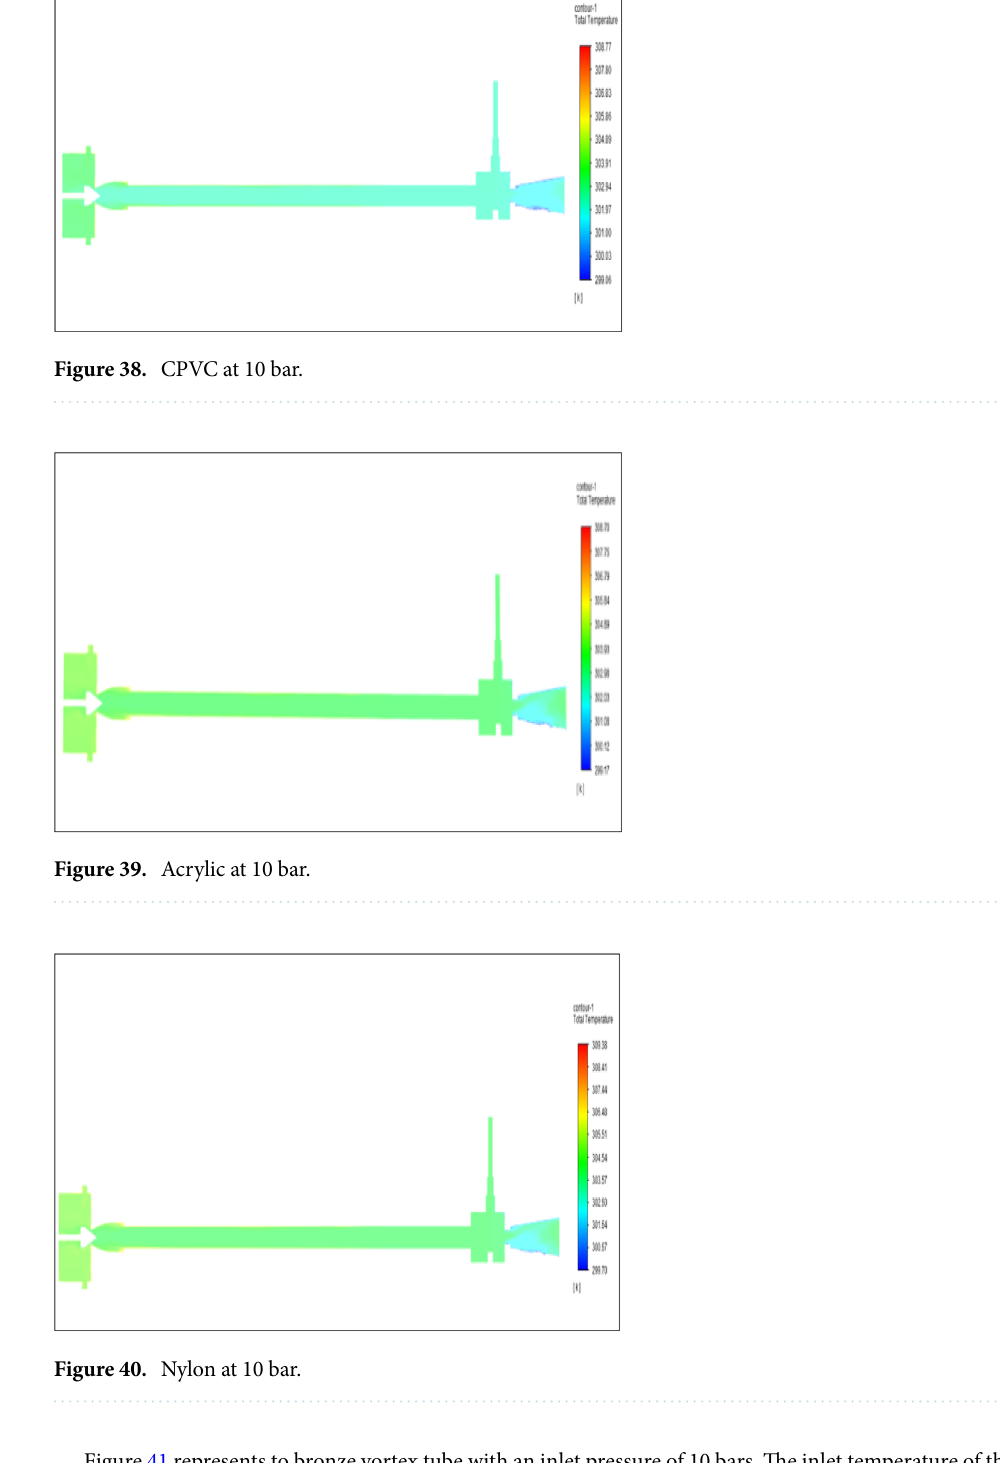
Figure 41 represents to bronze vortex tube with an inlet pressure of 10 bars. The inlet temperature of the VT is 303 K. The hot air temperature was obtained at the hot end as 309.40 K. Similarly at the cold end side obtained value was 298.75 K. The maximum temperature difference was noticed as 10.65 K. Figure 42 represents to copper vortex tube with an inlet pressure of 10 bars. The inlet temperature of the VT is 303 K. The hot air temperature was obtained at hot end as 309.85 K. Similarly at cold end side obtained a value of 298.70 K. The maximum temperature difference was noticed as 11.15 K.